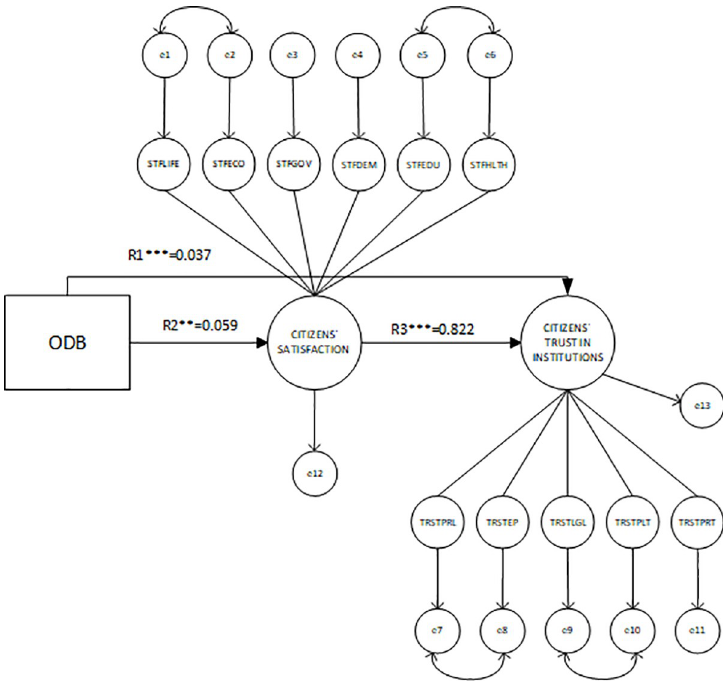
Fig 2. Measurement model. The rectangle depicts the implementation of OGD measured by the ODB score. The two largest circles are the latent variables for trust and satisfaction, two formative constructs built up from six and five indicators, respectively. Figures next to or above the arrows are the standardized regression weights, which are significant at a 0.001 level ( ��� ), except R 1 which is significant at a level 0.05 ( �� ). Residual (error) variables were added for every endogenous